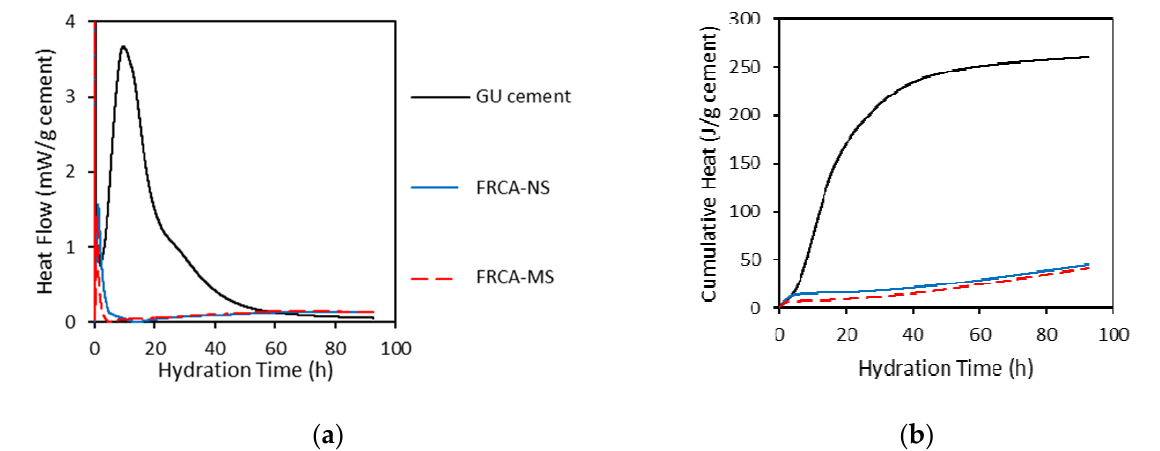
Figure 9. Isothermal calorimetry analysis: ( a ) heat flow curves and ( b ) cumulative calorimetric curves of original and powder FRCA samples.